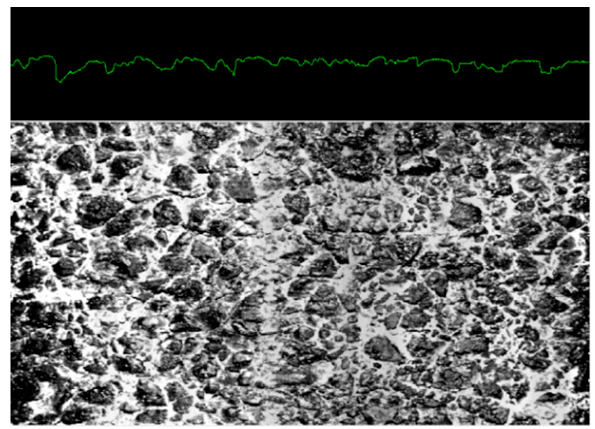
Figure 2. Texture profile and image on HMA surface (100 mm × 100